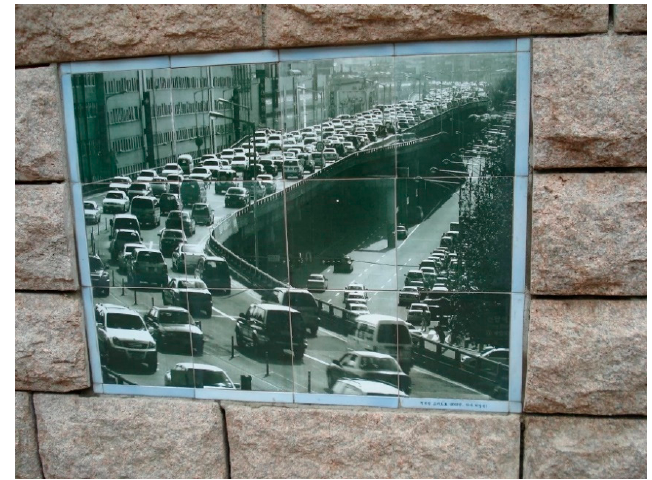
Figure 15. Image of the Cheonggyecheon highway overpass, dated 2003.